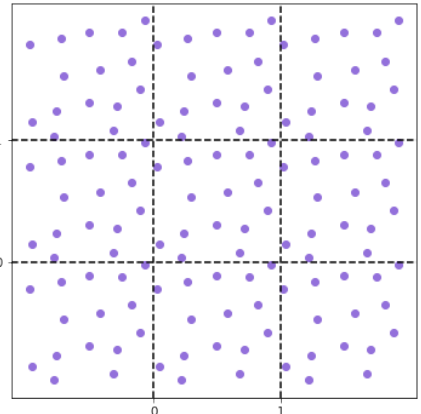
Figure 3. Simulating toroidal geometry by periodizing the initial set of